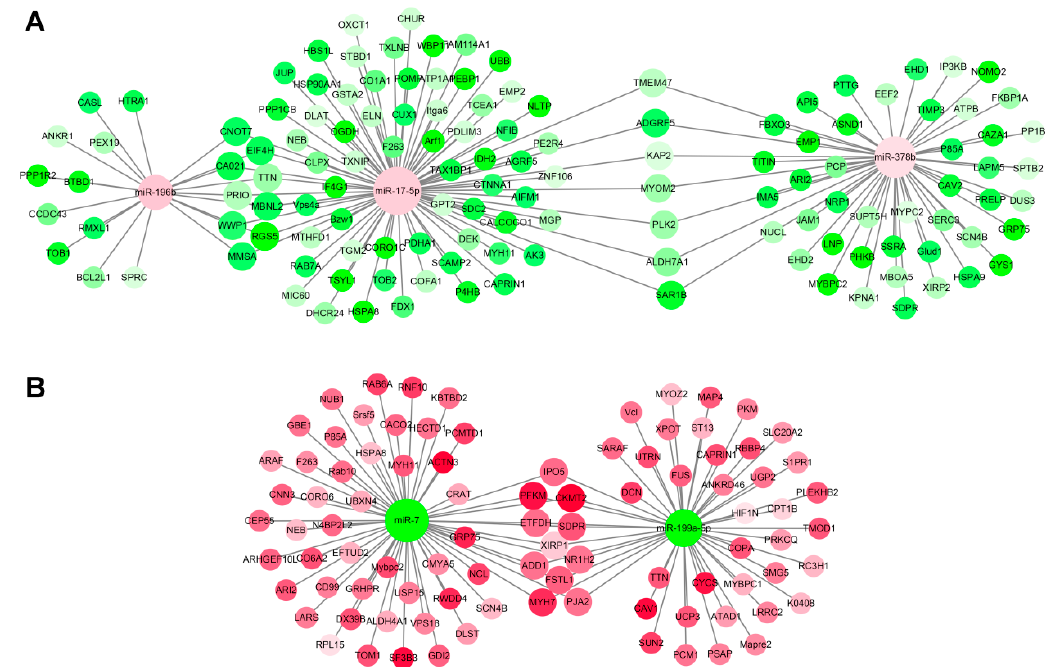
Figure 6. miRNA–mRNA interaction network associated with muscle aging in the sika deer. ( A ) Up-regulated miRNAs and down-regulated target genes related to muscle aging. ( B ) Down-regulated miRNAs and up-regulated target genes related to muscle aging. The up-regulated miRNAs or genes were displayed as red circle, and the down-regulated miRNAs or genes were displayed as green circles. Table 2. miRNAs identified in the skeletal muscle of sika deer as well as those associated with muscle development and aging in other species.